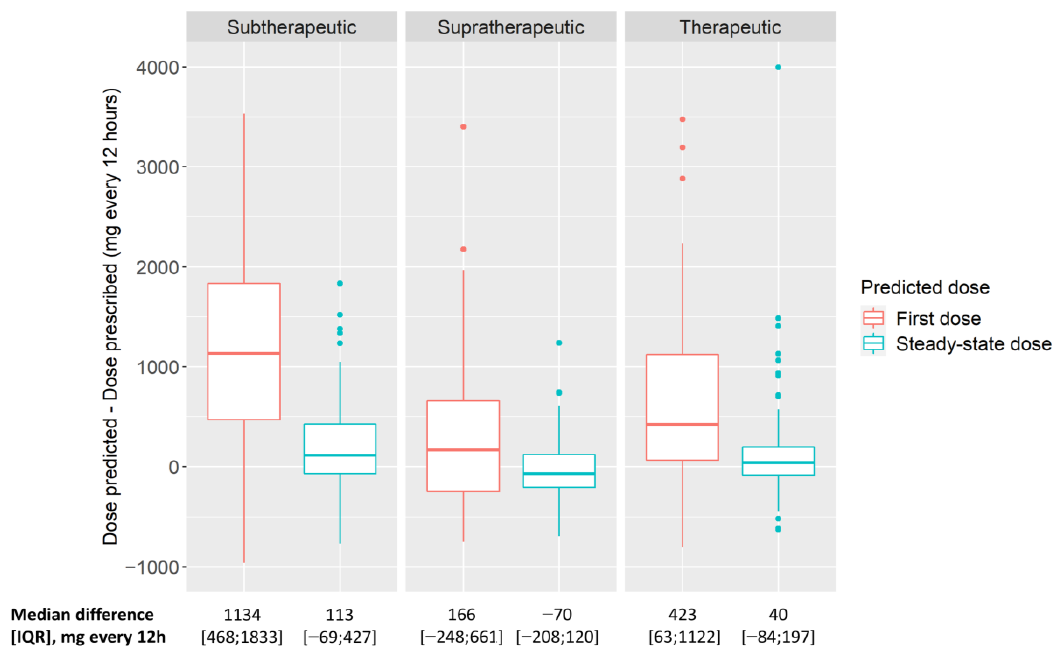
Figure 4. Boxplots of the difference between the vancomycin doses predicted by the MAA SSE approach and the prescribed vancomycin doses, including the median (interquartile range) difference. The doses were normalized to a twice-daily dosing regimen, i.e., the doses were expressed as dose q12h. The differences were shown in three groups depending on the exposure at the time of the second vancomycin concentration of each pair (i.e., subtherapeutic, supratherapeutic, or therapeutic). The vancomycin doses were predicted based on the first vancomycin concentration of each pair of concentrations. The red and blue boxplots represent the dose differences based on the first and second dose predicted to reach therapeutic exposure, respectively. The therapeutic exposure was defined as concentrations between 12.5–17.5 mg/L or between 20–25 mg/L for intermittent or continuous infusion,